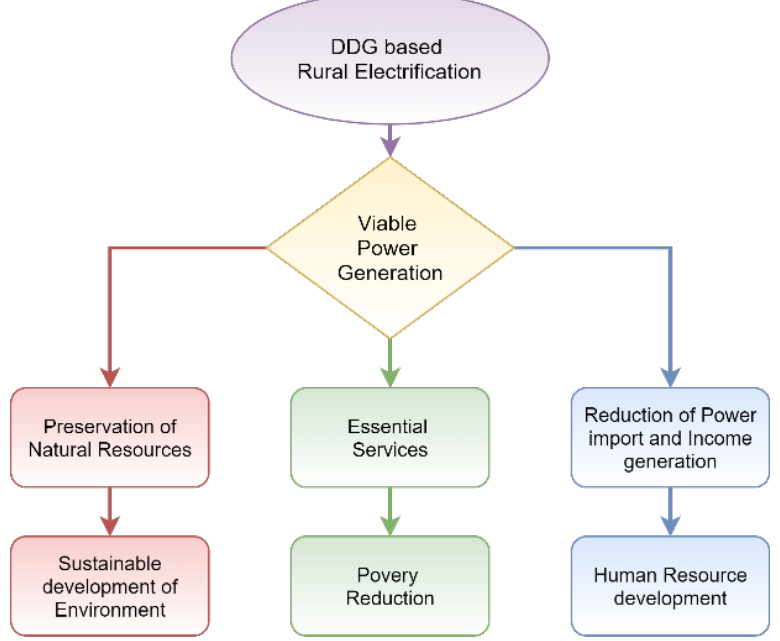
Figure 2. Various advantages of decentralized distributed generation.